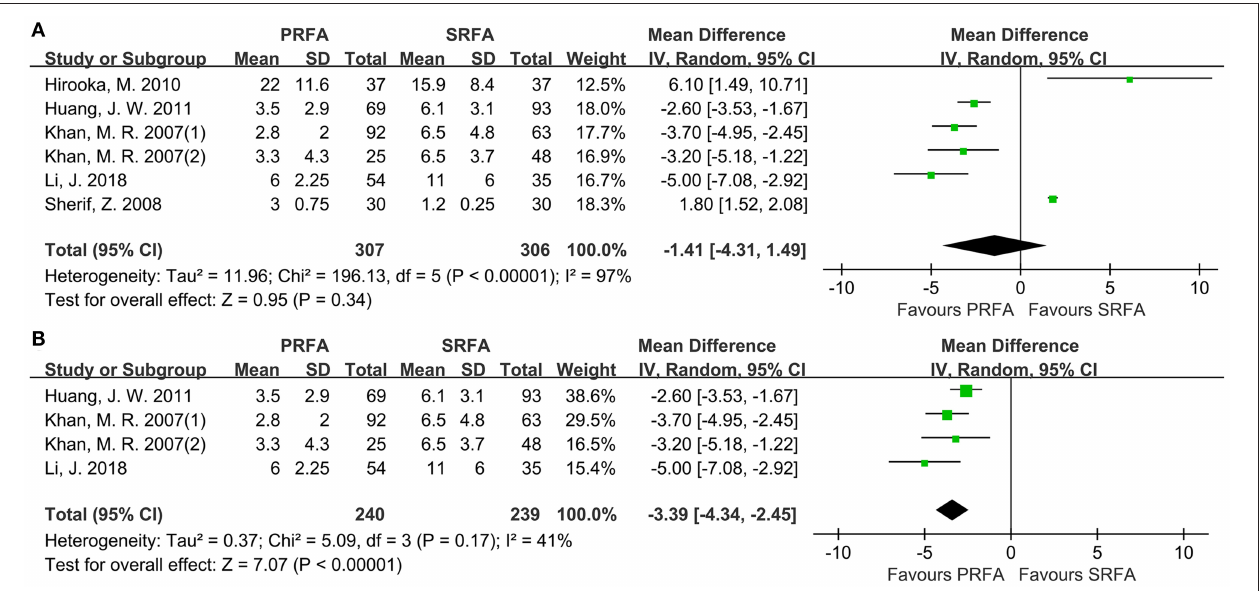
FIGURE 5 | Forest plot for length of hospital stay. (A) Forest plot for length of hospital stay indicates no significantly between the PRFA group and the SRFA group (WMD, 0.61 days longer in the SRFA group; 95% CI, − 3.28–2.06; p = 0.65; ( χ 2 = 161.19; p < 0.00001, I 2 = 97%). (B) Forest plot for sensitivity analysis of length of hospital between PRFA and open approach showed that PRFA group had a significant reduced hospital duration (WMD, 1.4 days longer in the SRFA group; 95% CI, − 4.34 to − 2.45; p < 0.00001; χ 2 = 5.09; p = 0.17, I 2 =